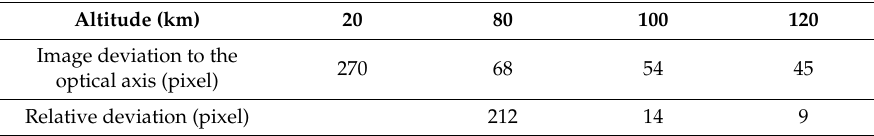
Table 2. Image deviation on the ICCD active area at di ff erent altitudes.